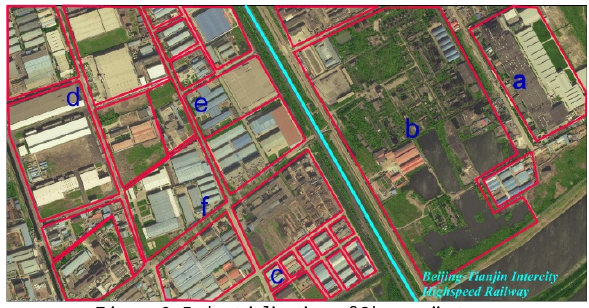
Figure 6. Industrialization of Shuangjie town Table 1. Some companies in the town